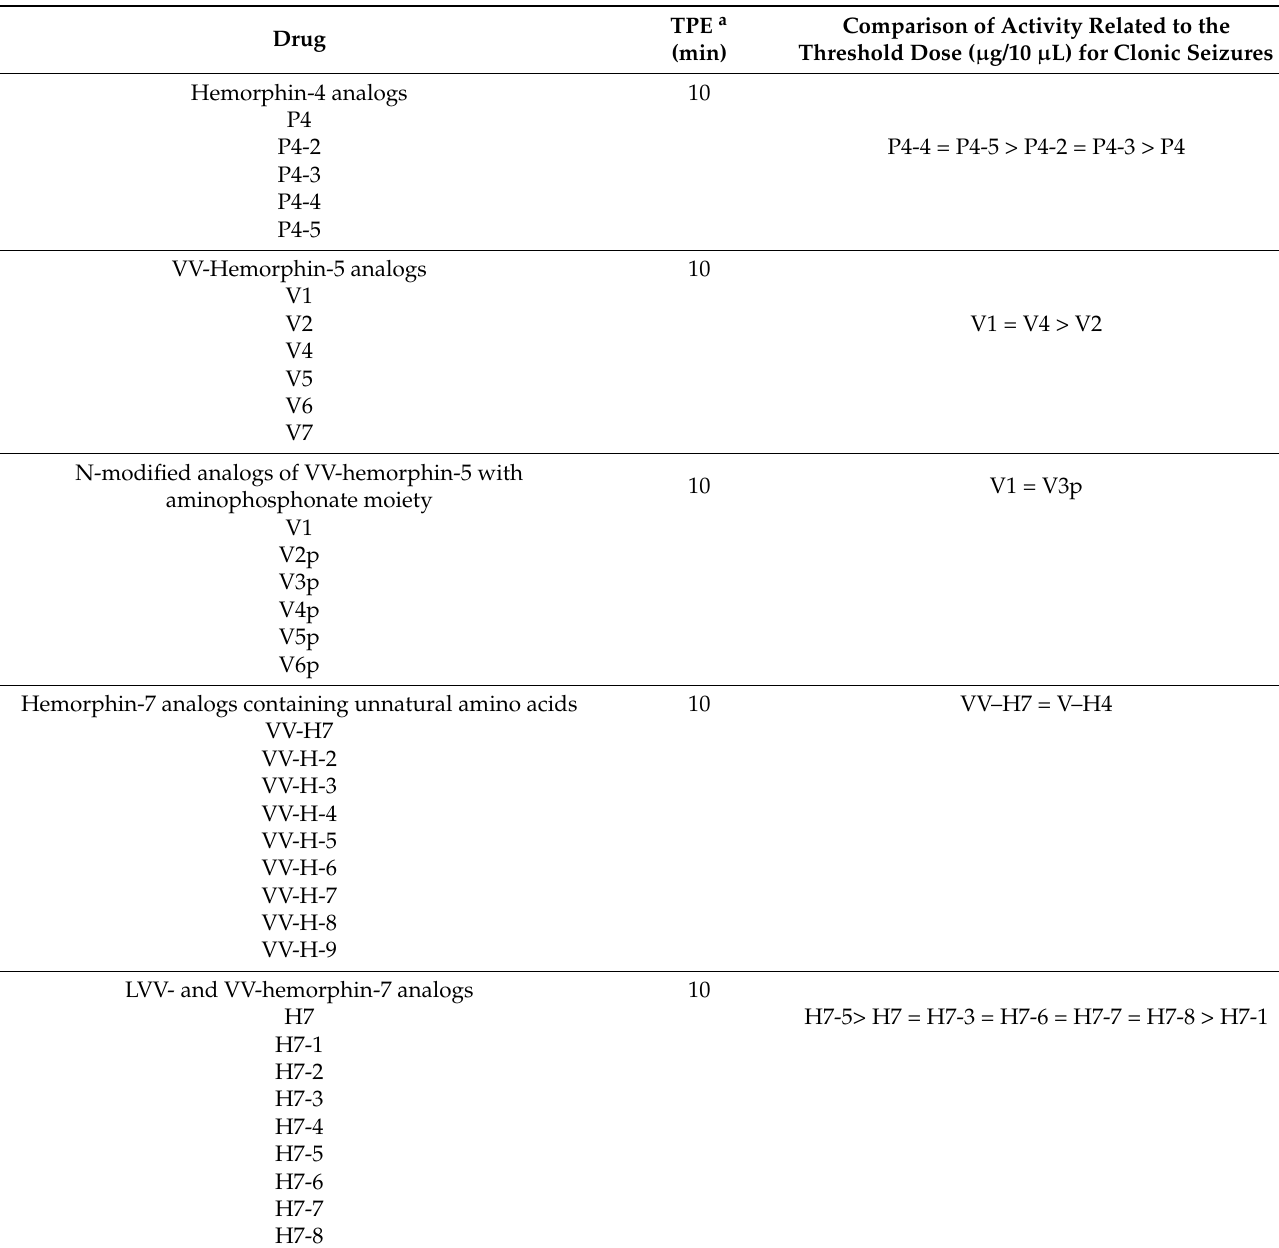
Table 4. Analysis of anticonvulsant activity of hemorphin peptides in iv PTZ seizure test in